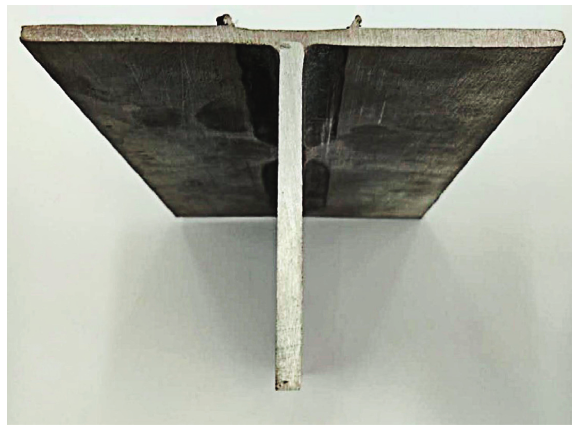
Figure 6: Overall appearance of a welded